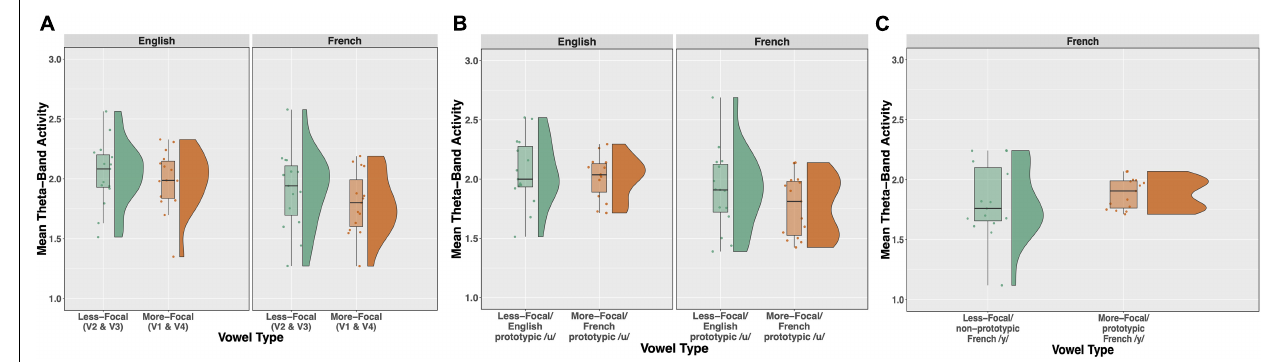
FIGURE 9 | Raincloud plots, which combine boxplots and split-half violin plots, of theta-band activity elicited in response to the vowel stimuli. (A) Theta activity for the relatively less-focal vowels (V2 and V3) versus more-focal vowels (V1 and V4) plotted as a function of each language group (English vs. French). (B) Theta for the more-focal /u/ (V1) versus less-focal /u/ (V2) for each language group. (C) Theta for the less-focal, non-prototypic /y/ (V3) vs. more-focal prototypic /y/ (V4) for French listeners. There was a main effect of vowel type in panels (A,B) , such that theta was lower for the more-focal vowel variants, and this effect was significant within each language group (see text for further